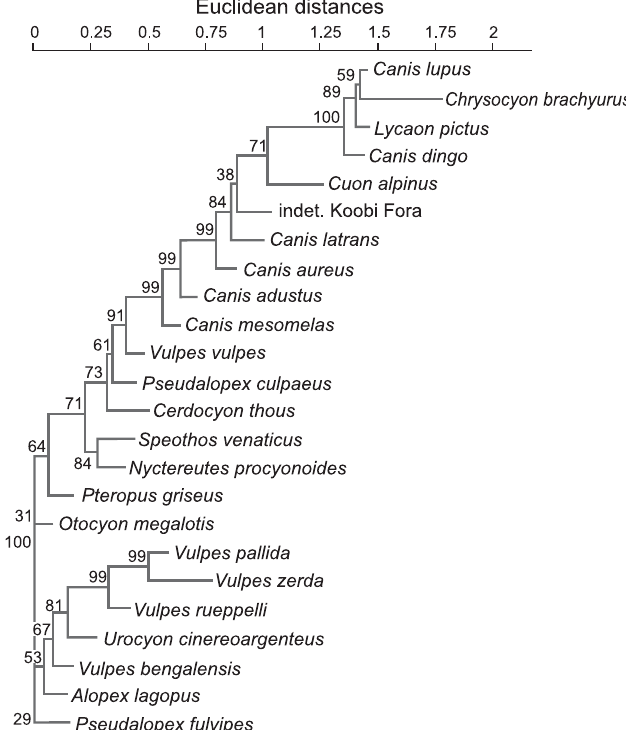
Fig. 4. Neighbour-joining cluster analysis performed using Euclidean dis- tances extracted from all measurements. Bootstrap values show the support for each internal node.